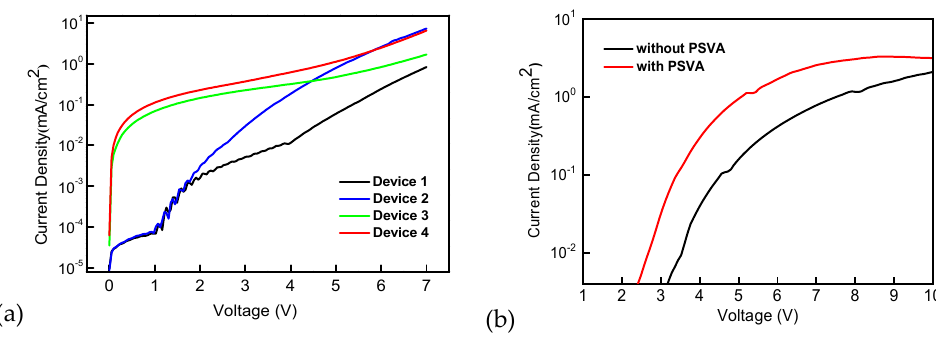
Figure 3. JV characteristics of hole-only devices ( a ) and electron-only devices ( b ). Table 1. Comparison of the device performance of solution-processed blue OLEDs, based on DMAC-DPS.